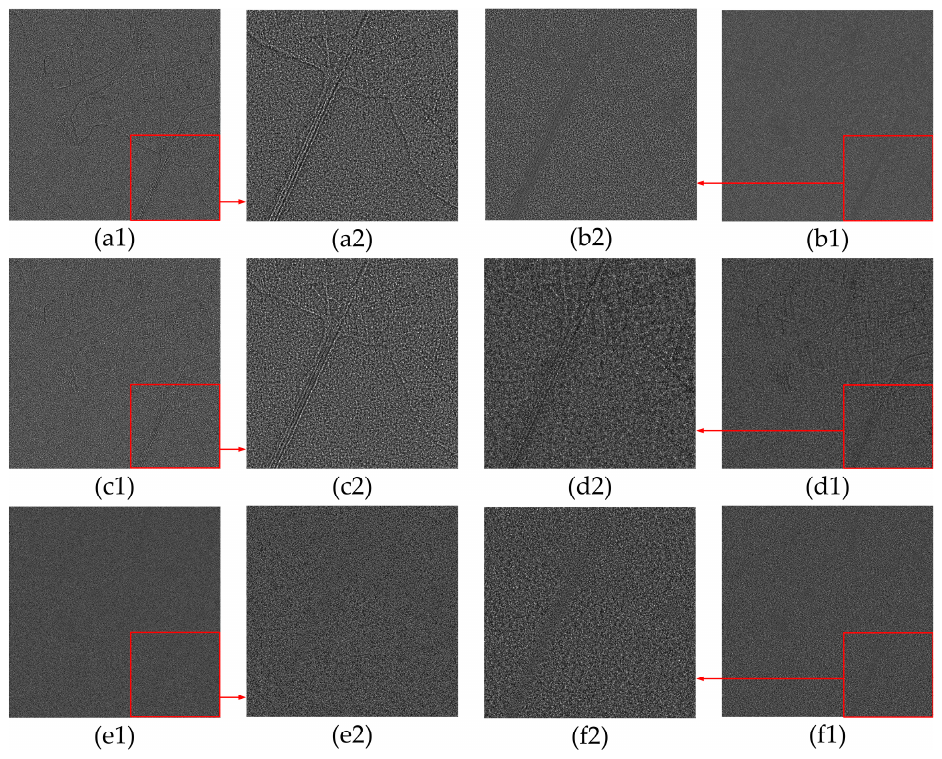
Figure 11. Ratio images by noisy RadarSAT-2 SAR image and the ( a1 ) SRAD, ( b1 ) DPAD, ( c1 ) EnLee, ( d1 ) PPB, ( e1 ) SAR-BM3-D, and ( f1 ) FANS filtered images. ( a2 – f2 ) are the enlarged images of the red rectangle from ( a1 – f1 ).